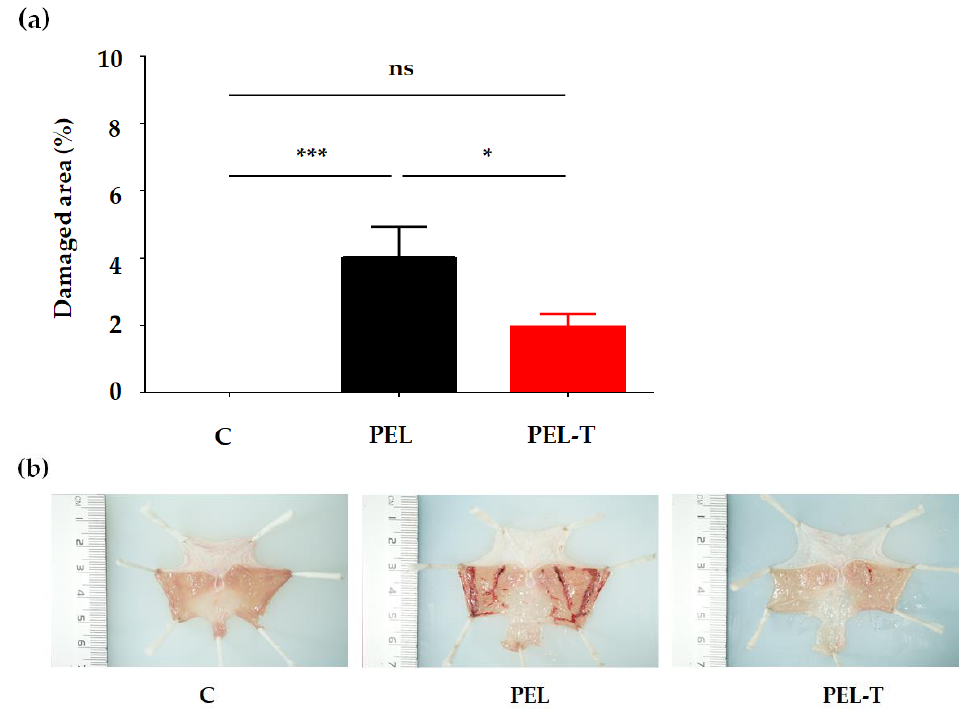
Figure 3. ( a ) Damage area (%) in the gastric mucosal injury test of rats, which was assessed using the image program (ImageJ software). Each value represents the mean ± S.D. ( n = 10) (*** p < 0.001 level compared to C; * p < 0.05 level compared to PEL; ns, no significant difference). ( b ) Representative gastric mucosal lesion photographs of each group; C, normal control.